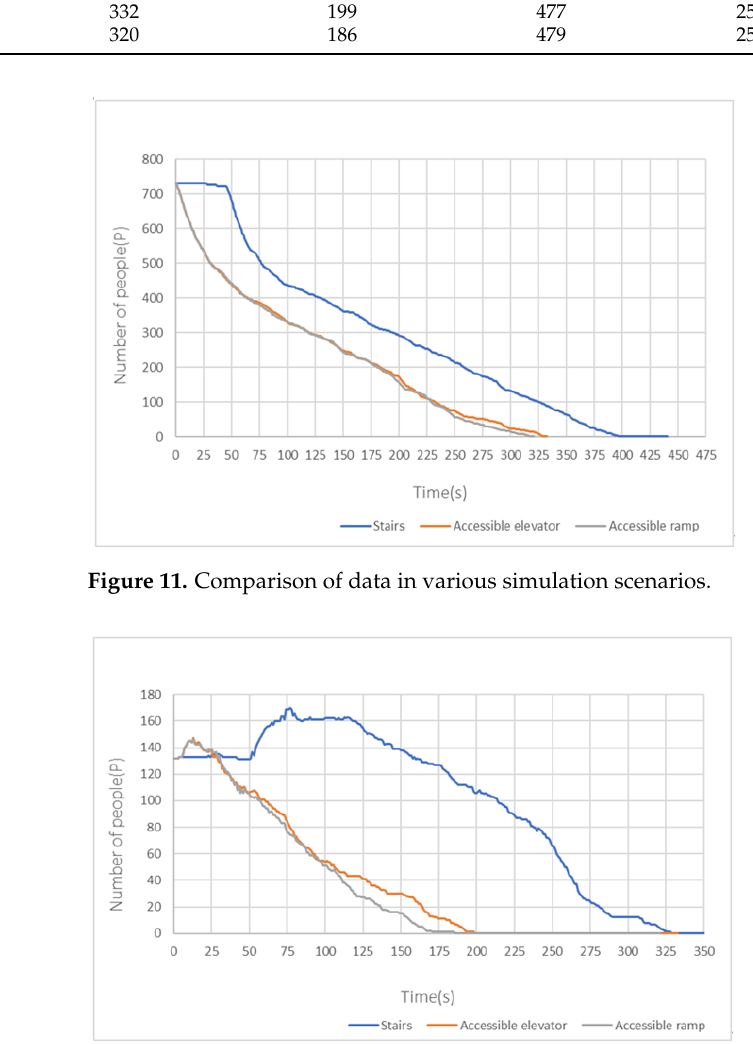
Figure 12. Comparison of the number of people in the front room of each evacuation ladder on the third floor.